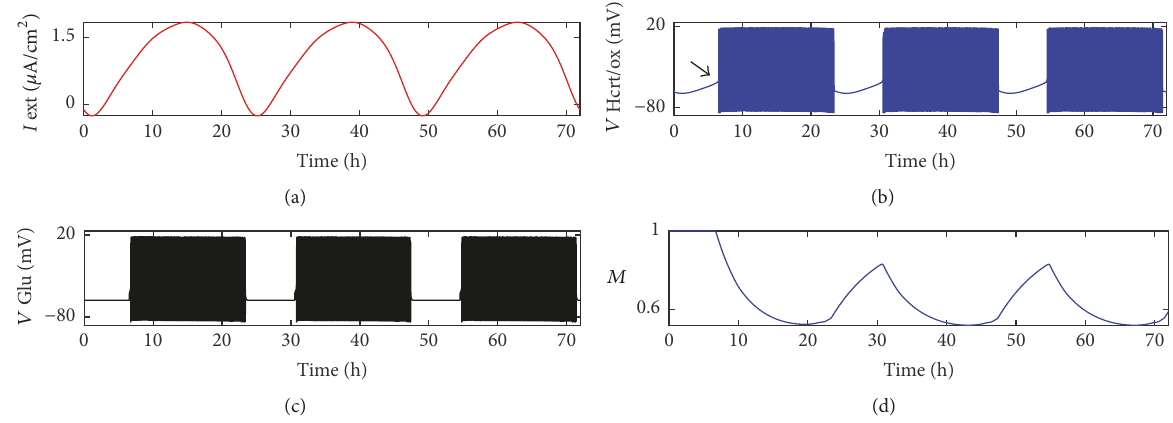
Figure 1: An illustration of the mathematical model of homeostatic regulation of sleep-wake cycles, the coupled Hcrt/ox (b), and Glu (c) of sleep-wake cycles activities, respectively, under one typical amplitude of external current input 𝐴 = 1.0𝜇 A/cm 2 (a), and the variety of regulation function 𝑀 (d). Moreover, the increased amplitude of external current input will advance wake time but slightly change sleepy